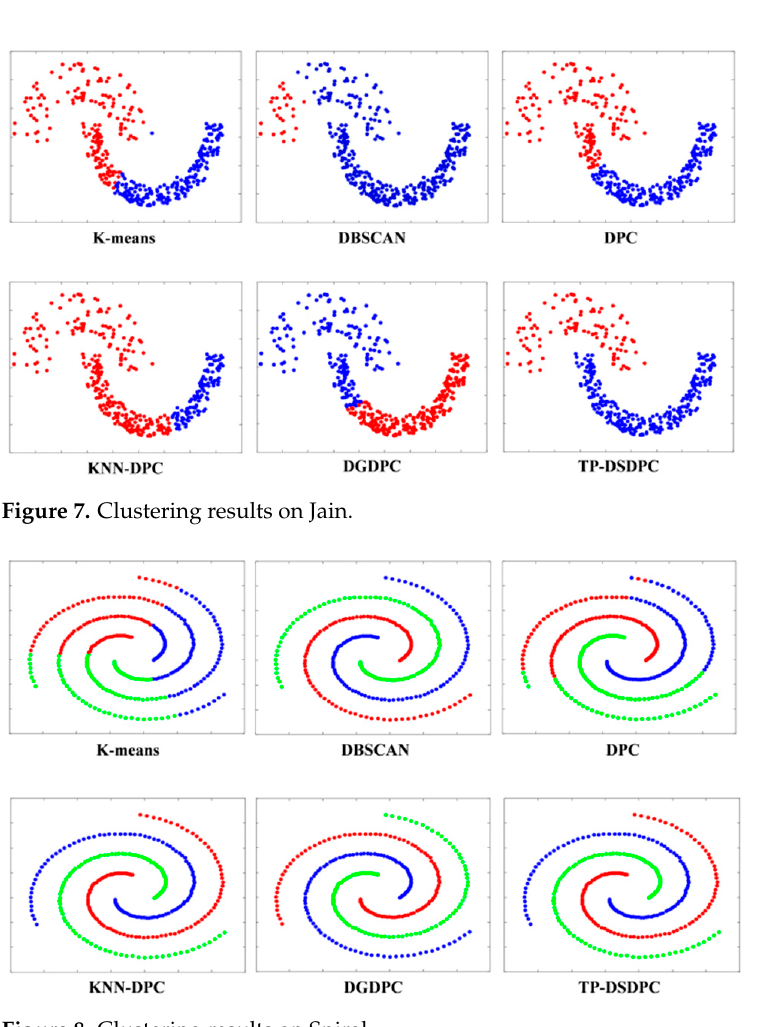
Figure 8. Clustering results on Spiral. Only DBSCAN, DGDPC and TP-DSDPC had successful clustering results for the Three- circles dataset according to the clustering findings in Figure 9. This may be because other algorithms cannot recognize circular datasets. Figure 10 illustrates that most of the algo- rithms can perform well on the Smile dataset, except for K-means and DBSCAN. Figure 11 demonstrates that most algorithms can find proper clusters on the Fourlines dataset.